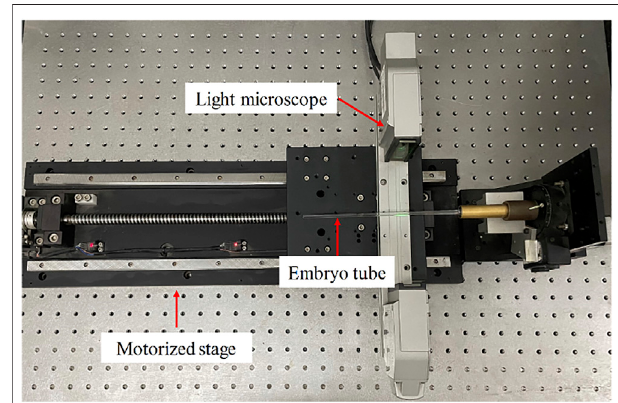
FIGURE 3 | Photograph of the optical test platform based on a light